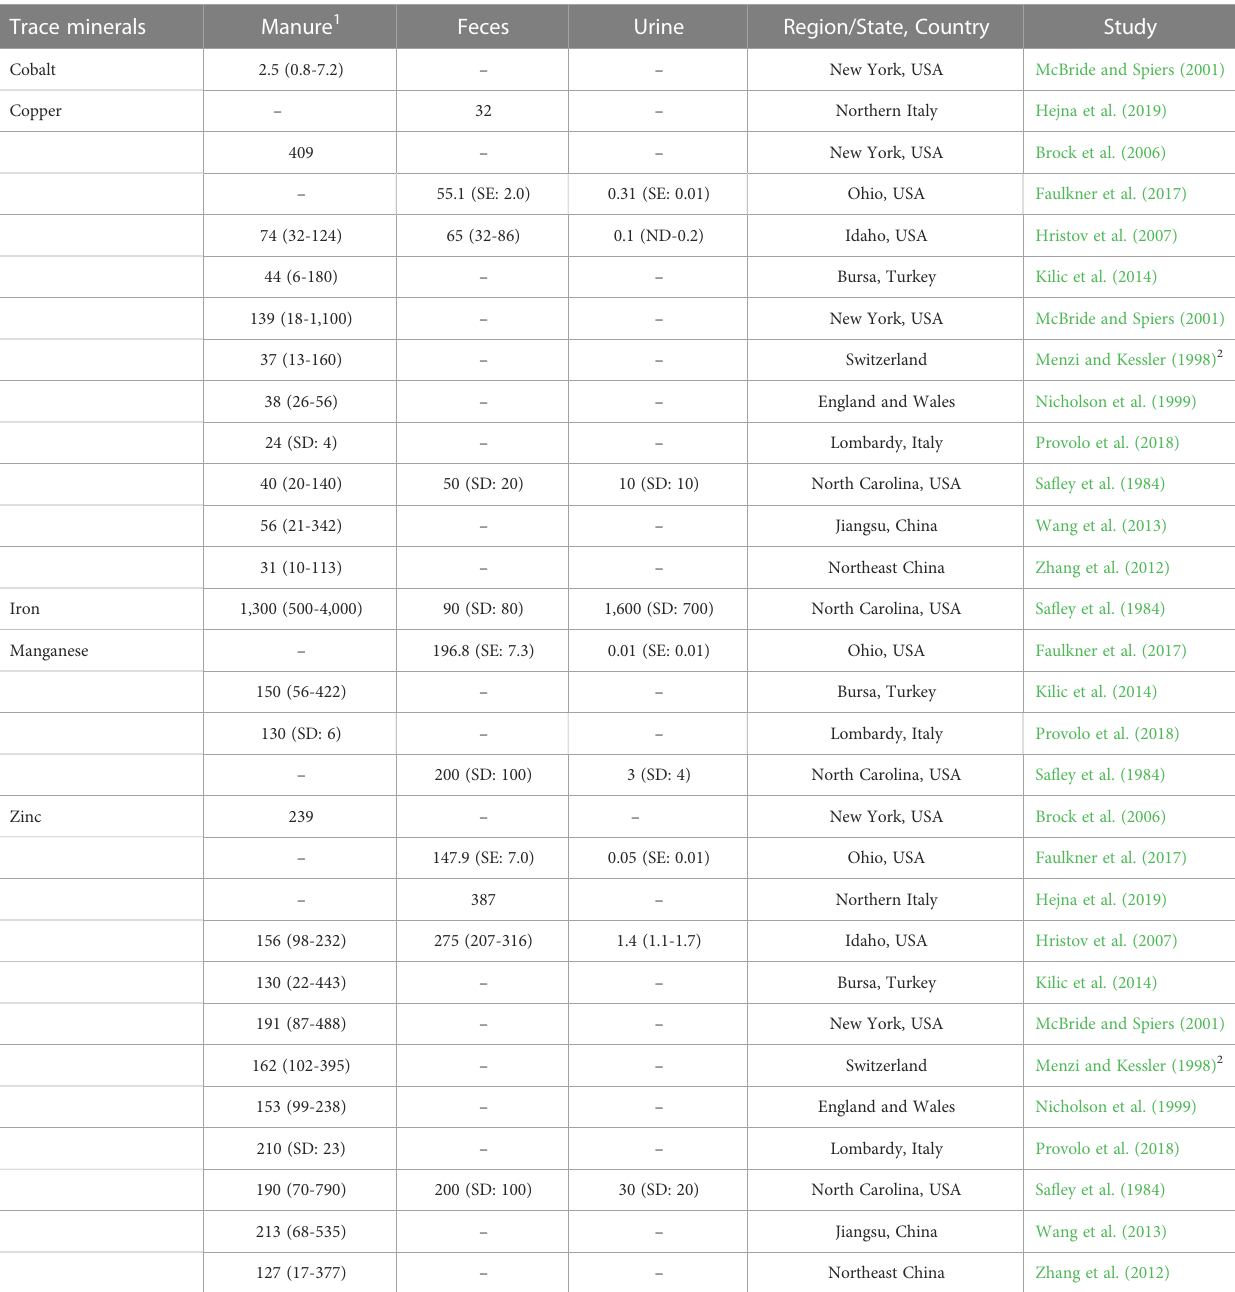
TABLE 2 Manure, feces, and/or urine concentrations (mg/kg of dry matter) of cobalt, copper, iron, manganese, and zinc of dairy cows from different